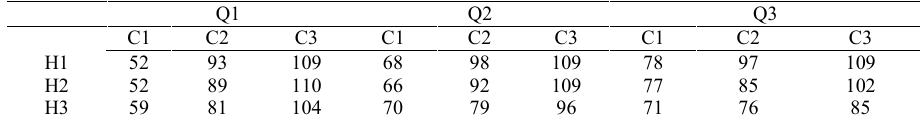
Table 5: Toe position (X toe ) (cm) in the final steady state condition in all the experiments Q1